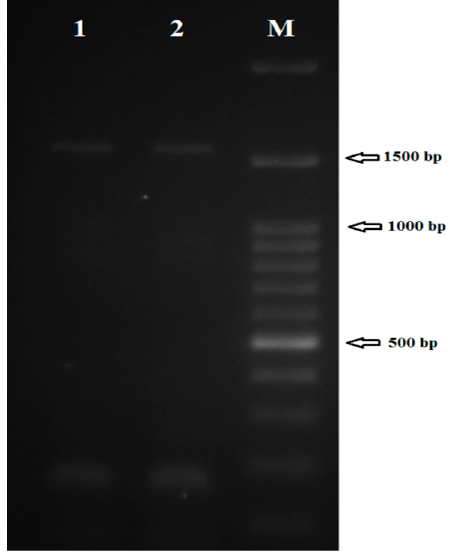
Figure 1. Amplification of the complete coding region of CYP51 in a wild-type (lane1) and strain MRHO/IR/75/ER of L. major . M: DNA ladder.